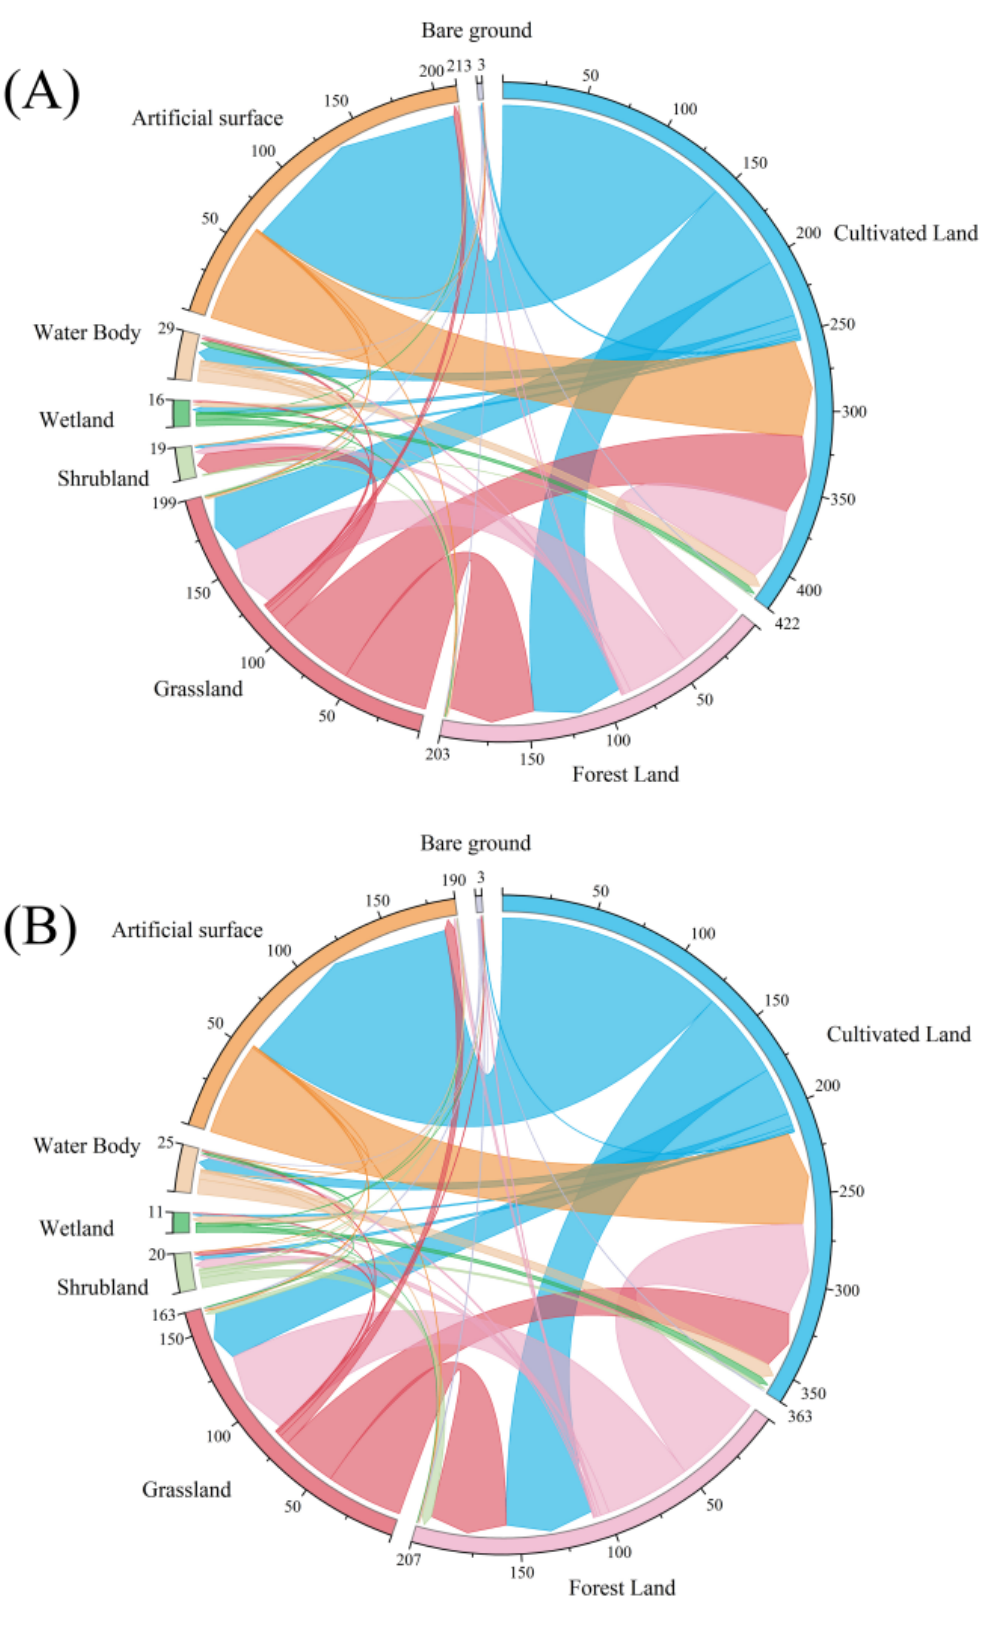
Figure 2. Chord diagram of land use transfer: ( A ) 2000–2010; ( B ) 2010–2020.